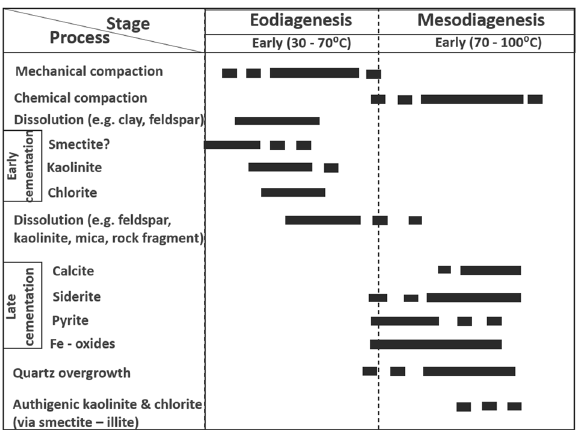
Figure 10. Paragenetic sequence of diagenesis in the studied Bentiu Formation. Note: the sequence here follows boundaries discussed in 44,46 using CorelDRAW Graphics Suite 2018 v20.0.0.633 https:// www. corel. com/ cn; the temperature data indicated are interpretive and such should be treated with